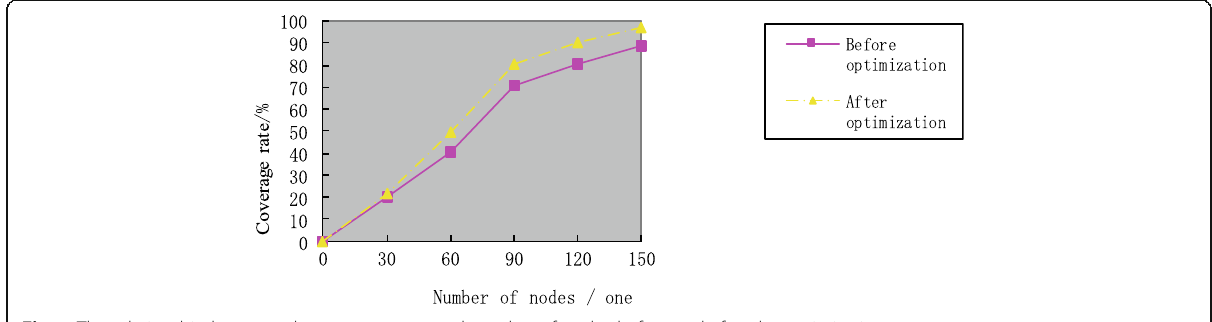
Fig. 7 The relationship between the coverage rate and number of nodes before and after the optimization